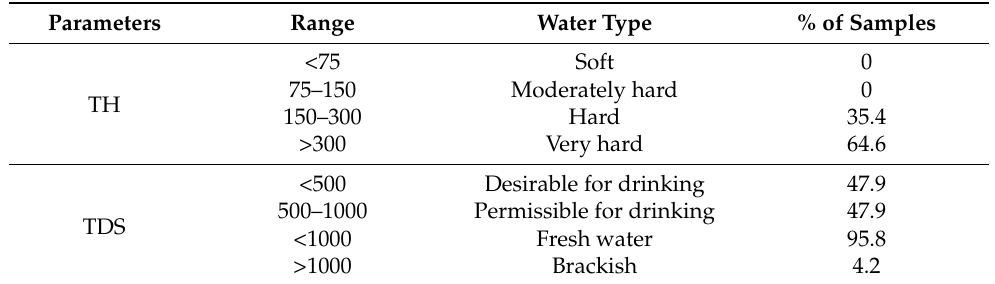
Table 2. TDS and TH-based classification of groundwater for drinking purpose in Tongchuan.